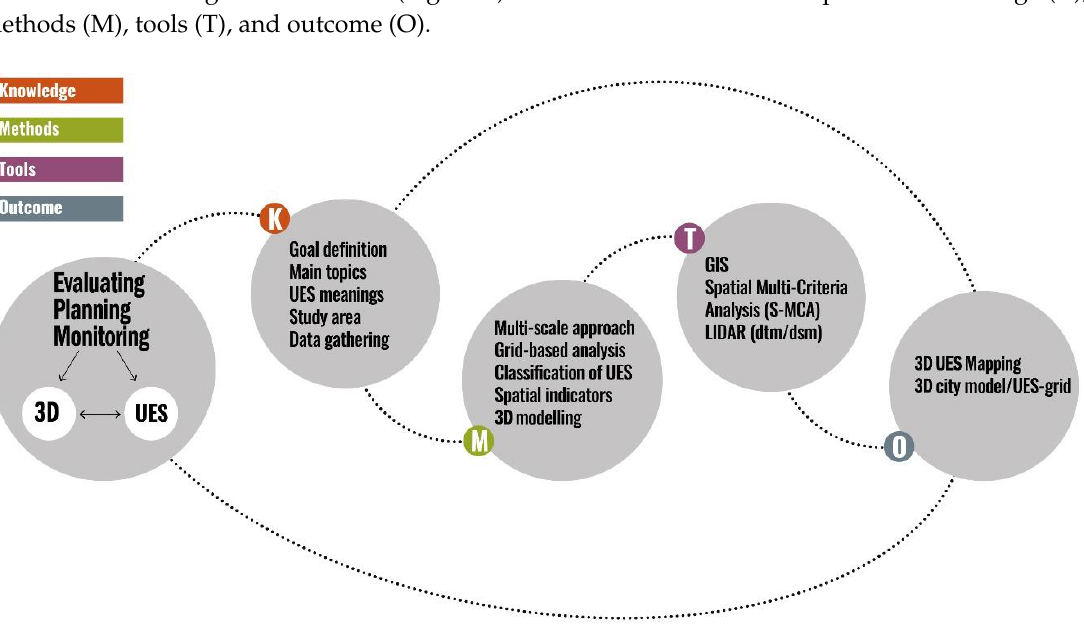
Figure 1. The methodological workflow.